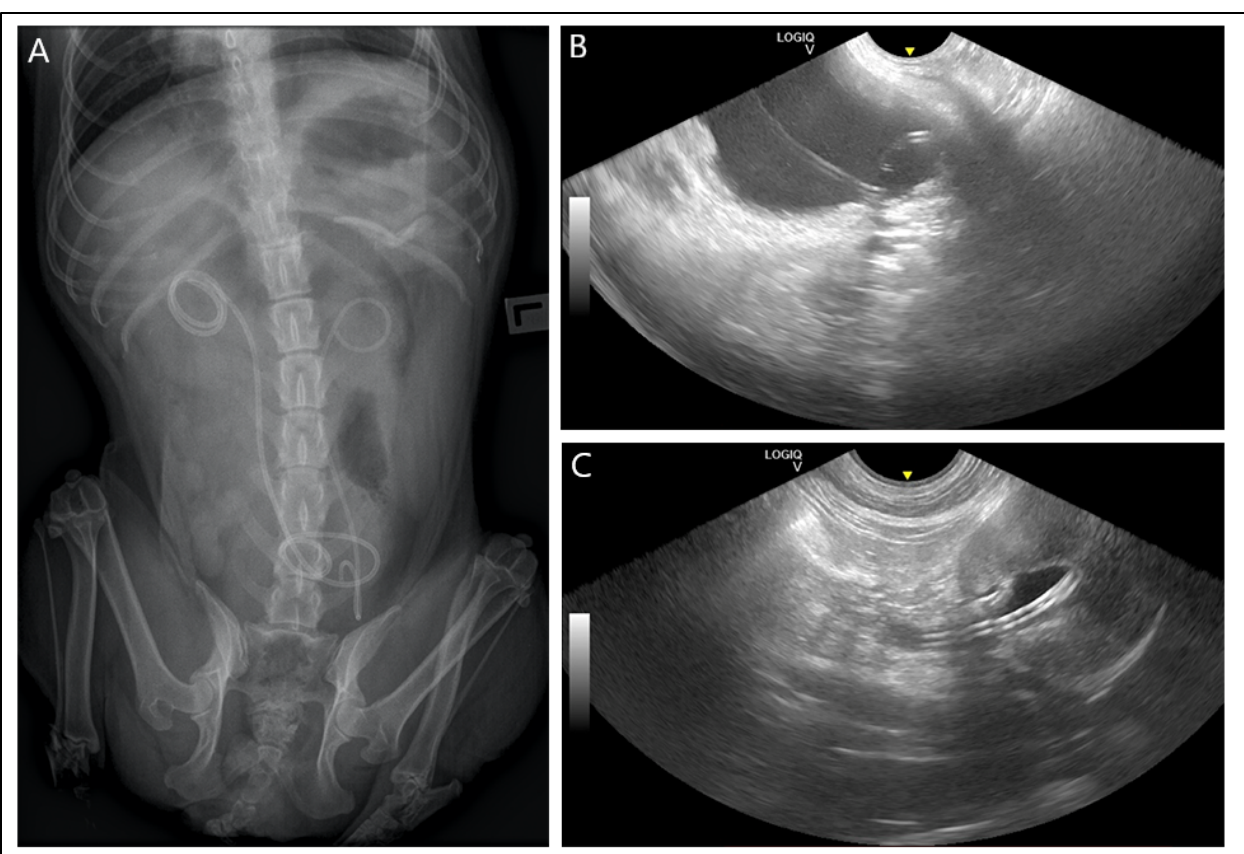
Figure 4. ( A ) Dorsoventral X-ray view of an animal with a double-pigtail stent positioned bilaterally in the ureters. ( B ) Ultrasound image of the end of a pigtail stent in the urinary bladder. ( C ) Ultrasound image of a pigtail stent placed in the renal pelvis. The photos were taken during the veterinary services of Dr Dariusz Jagielski. Table 2. Some complications after the stent placement procedure.